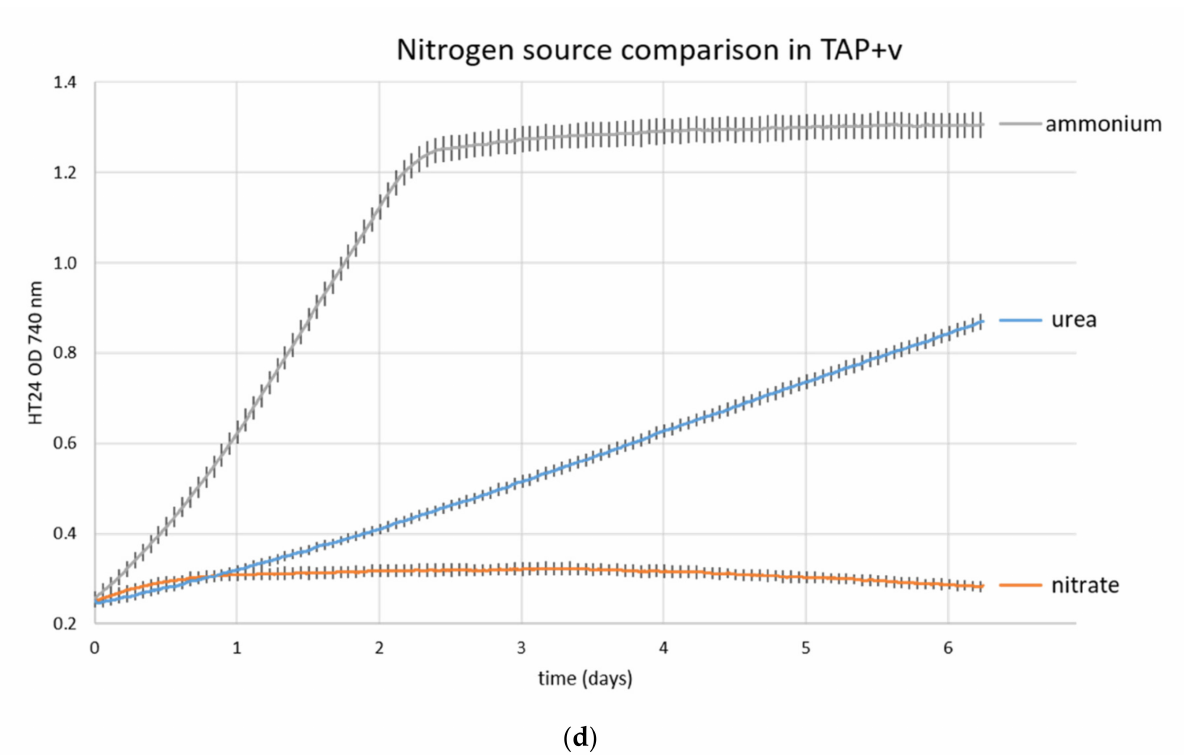
Figure 1. Growth of Chlorella variabilis in different media compositions. ( a ) Comparison of growth in TAP and TAP with added vitamins (TAP+v); ( b ) comparison of growth in HSM+v, TAP+v, and MBBM; ( c ) impact of carbon sources in HSM+v medium in comparison with TAP+v medium; ( d ) effect of nitrogen sources on cell growth in TAP+v medium. The plotted values are the average of 3 biological replicates with standard